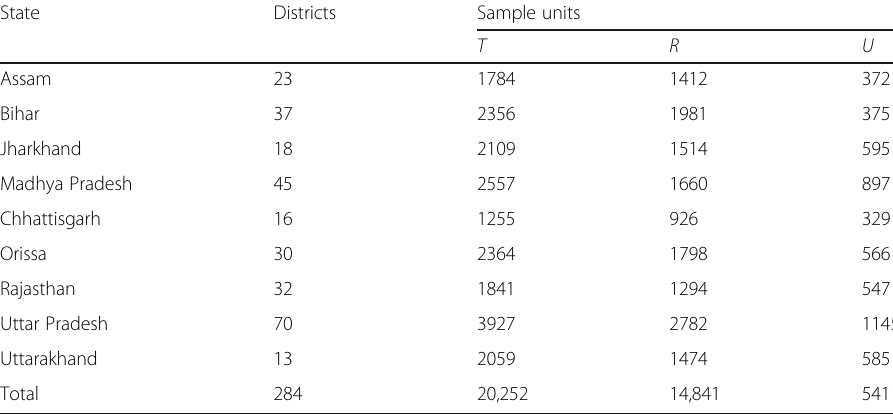
Table 5 Sample size of annual health survey by states State Districts Sample